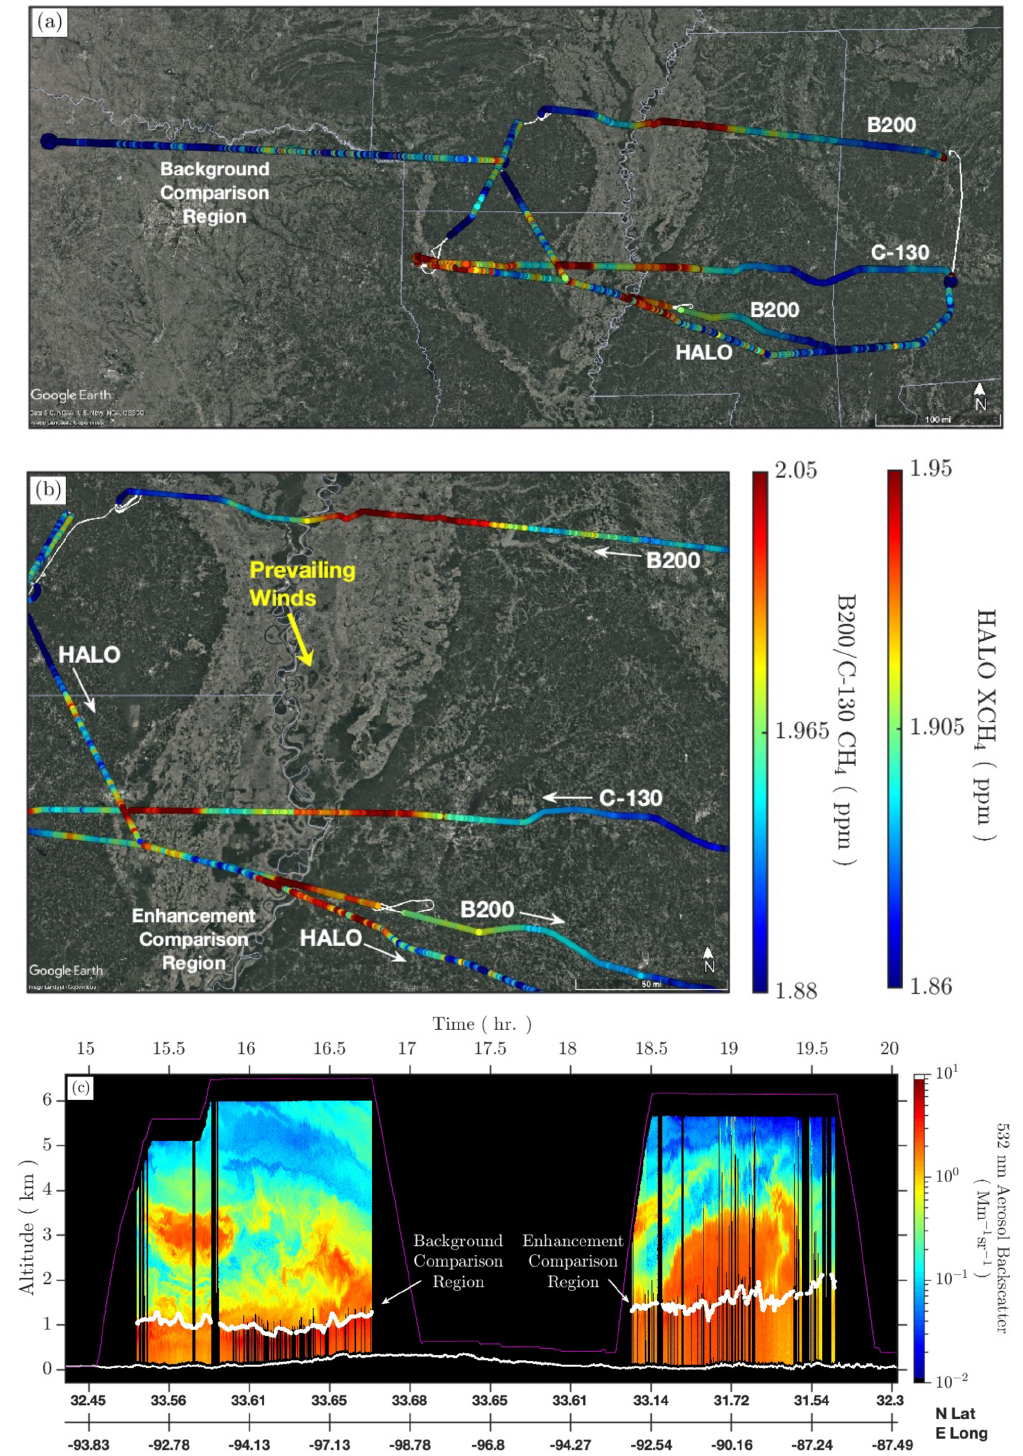
Figure 14. Overlapping flight lines between the C-130 and B200 aircraft in the southern Mississippi River valley region from the 27 June flight. (a) Combined flight lines for low altitude PBL in situ observations from C-130 and B200 and HALO XCH 4 from the C-130 at high altitude (©Google Maps). (b) Strong regional correlation can be seen between all three instruments, HALO at high altitude and the C-130 and B200 PBL observations at low altitude (©Google Maps). Prevailing winds measured in situ within the PBL indicate a NW flow during the observation period. (c) HSRL aerosol backscatter for the high-altitude C-130 legs with the PBLH